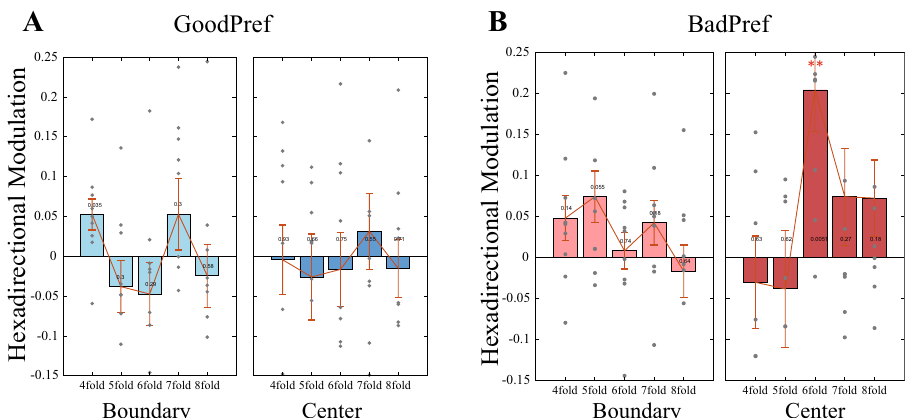
Figure 4. Spatial characteristics of the two groups of hexadirectional modulation. ( A ) All types of periodic rotation symmetries of the GoodPerf group are not significant in the space boundary region and the central region ( t test, p > 0.05). ( B ) The BadPerf group shows no obvious directional modulation in the boundary region, but displays significant six-directional modulation in the central region ( t test, p =